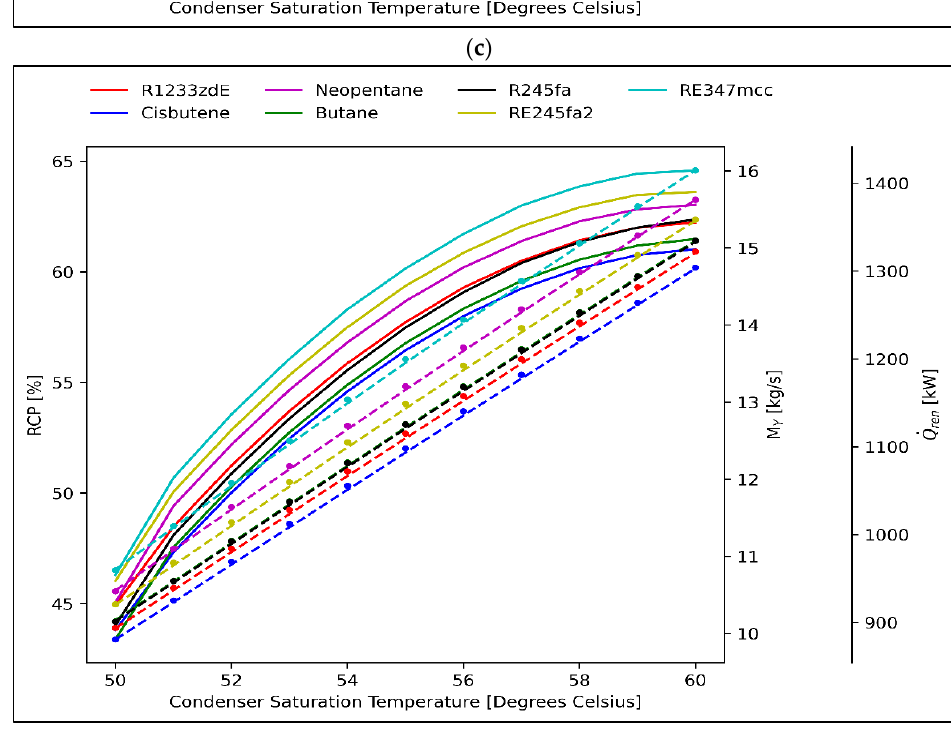
Figure 8. Condenser saturation temperature vs. reduction in power consumption and renewable energy input ( a ) at 90 °C; ( b ) at 100 °C; ( c ) at 110 °C; and ( d ) at 120 °C. Solid Lines: RCP , Dots: 𝑄̇ 𝑟𝑒𝑛 , Dashed Lines: M Y .